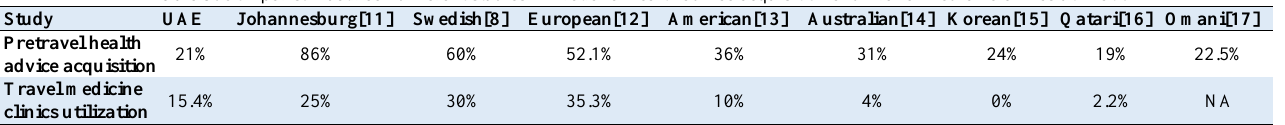
Table 3. Comparison between different studies in Pretravel health advice acquisition and Travel medicine clinics utilization Study